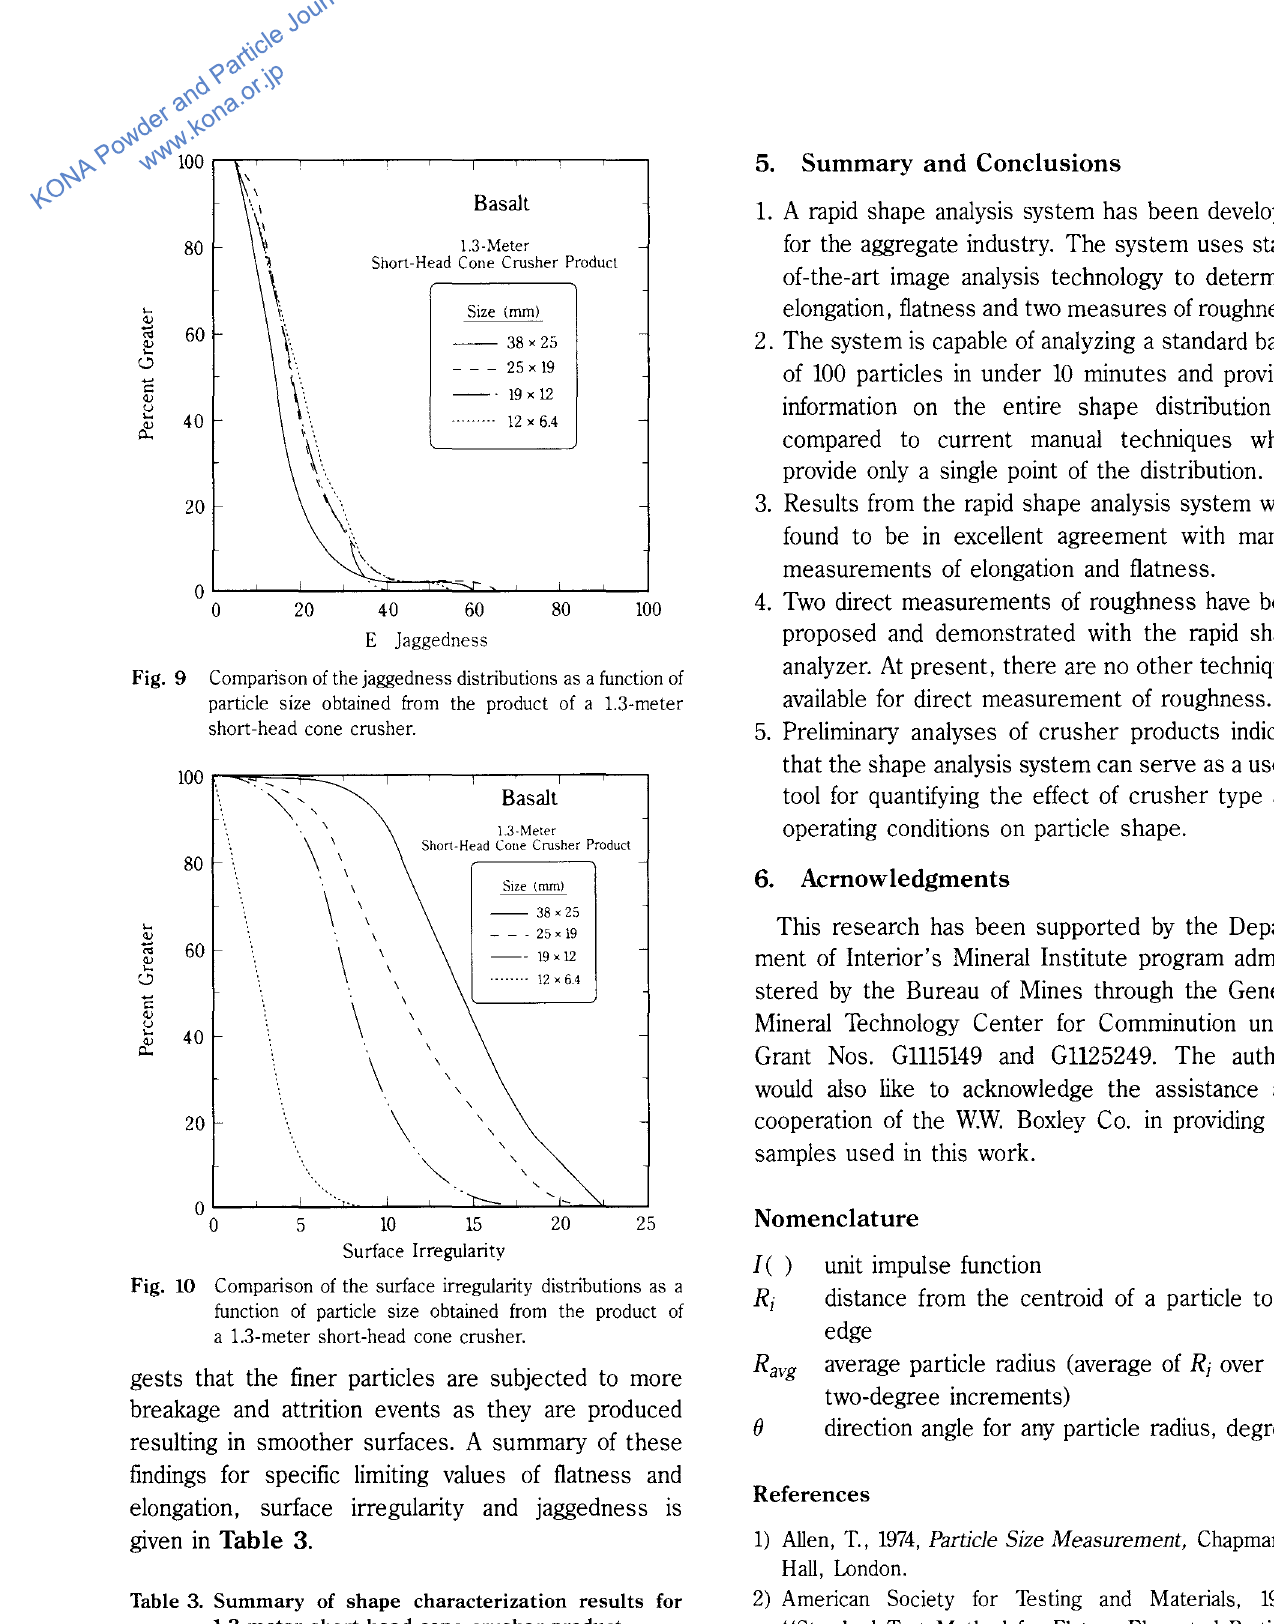
Table 3. Summary of shape characterization results for 1.3-meter short-head cone crusher